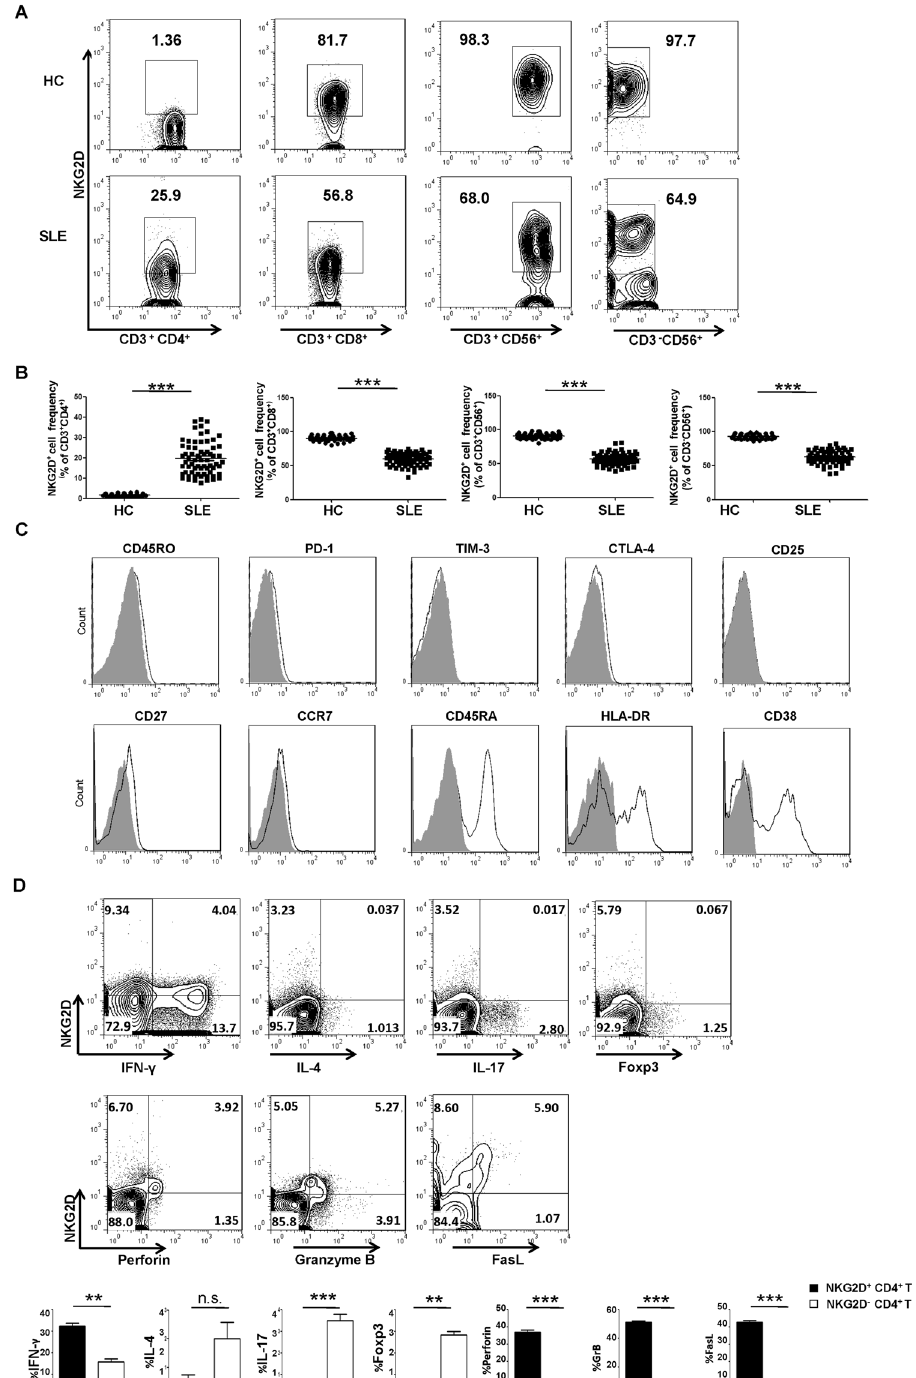
Figure 1. Identification and phenotypic characterization of NKG2D + CD4 + T cells in SLE. ( A ) FCM assay of NKG2D expression among CD4 + T, CD8 + T, NK and NKT cells in representative peripheral blood samples from a representative HC and SLE patient. ( B ) Frequency profiles of NKG2D expression on CD4 + T, CD8 + T, CD3 − CD56 + NK and CD3 + CD56 + NKT cells in the HCs (n = 46) and SLE patients (n = 66). Each symbol represents one individual. ( C ) NKG2D + CD4 + T cells were gated from a representative peripheral blood sample of an SLE patient and analyzed for expression of the indicated surface markers (black-lined histograms). Gray- filled histograms represent the staining with control Ab. ( D ) FCM assay of the expression of the indicated markers in gated CD4 cells from a representative peripheral blood sample of an SLE patient and statistical analysis of the frequency of the of CD4 + T cell subset in PBMCs of SLE patients (n = 30) and HCs (n = 30), respectively. Numbers represent percentages. Each symbol represents one individual; ** P < 0.01, *** P < 0.001. Horizontal lines with bars show the mean ±